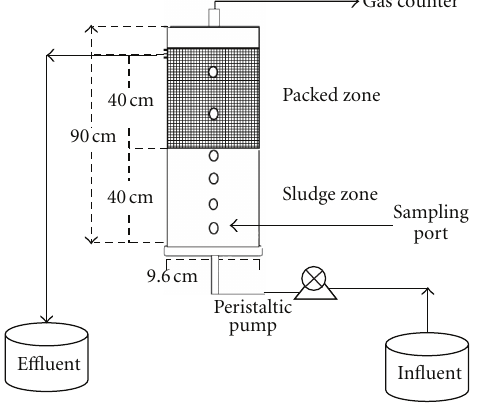
Figure 1: Schematic diagram of the laboratory-scale